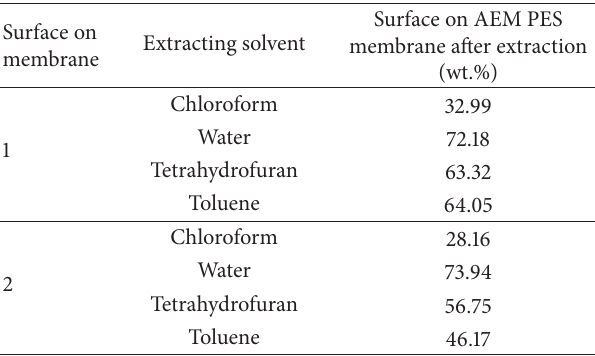
Table 2: Effect of extraction treatment using various solvents on the amount of extracted